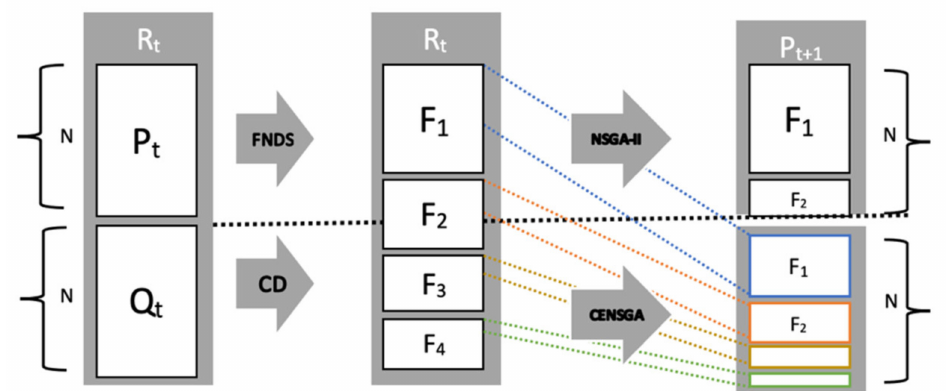
Figure 4. Selection strategy of CENSGA.